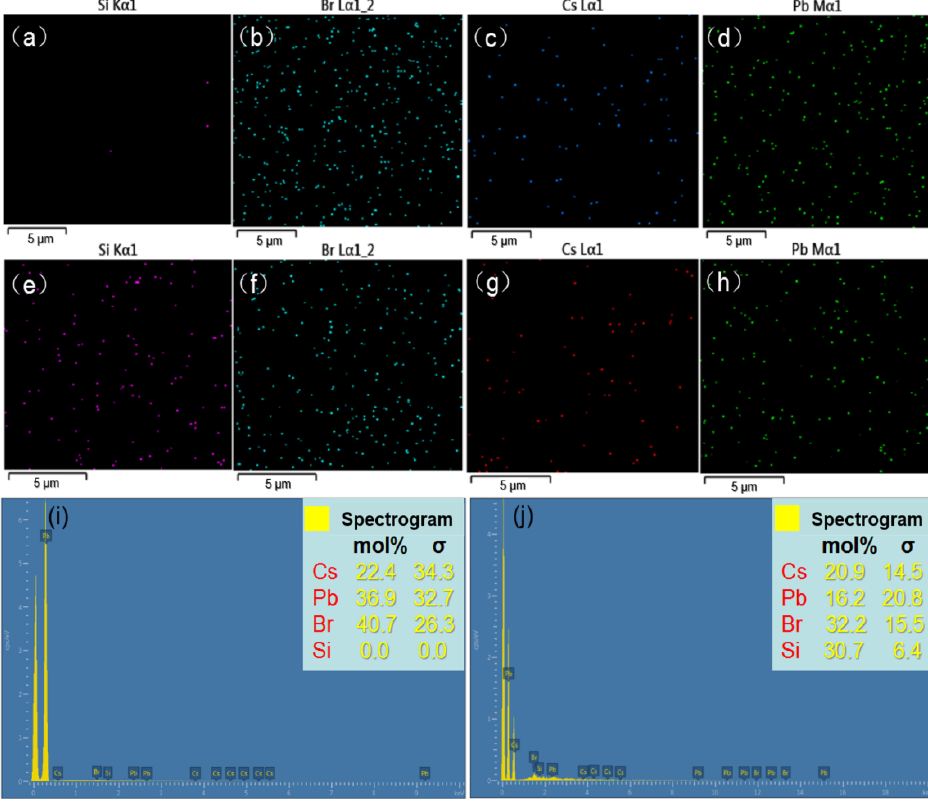
Figure 3. The EDS images of CsPbBr 3 QDs ( a – d ) and SBA-15@CsPbBr 3 QDs ( e – h ). The elemental proportion of CsPbBr 3 QDs ( i ) and SBA-15@CsPbBr 3 QDs ( j